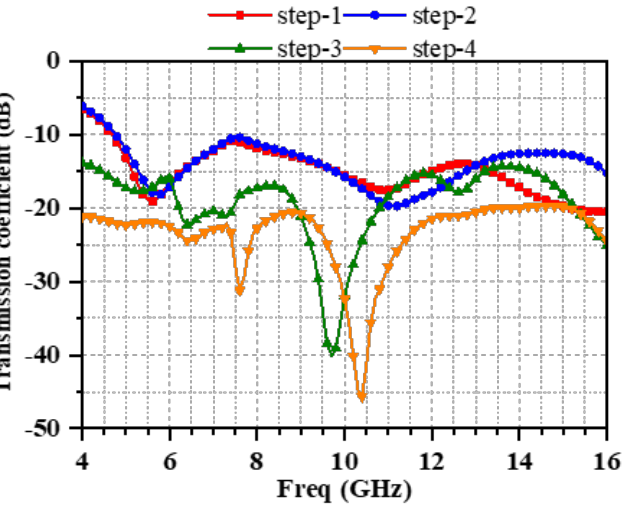
Figure 5. Comparison of transmission coefficients of 4 proposed UWB-MIMO antenna designs.